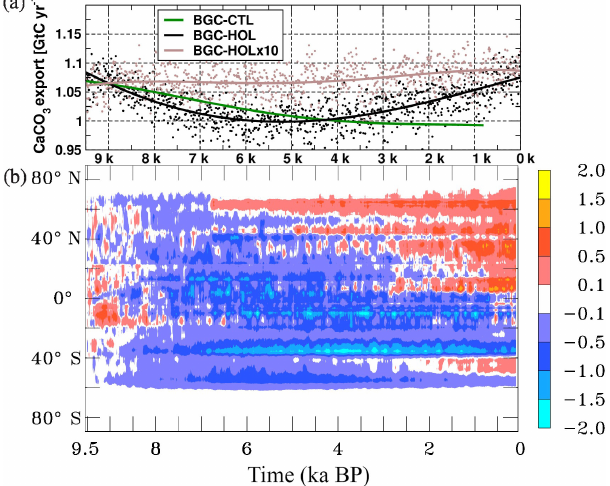
Figure 10. As Fig. 2 but (a) for time series of global export pro- duction at the bottom of the euphotic layer in GtCyr − 1 , and (b) Hovmöller diagram of the changes in zonal and annual mean global export production in mol Cm − 2 s − 1 × 10 9 .